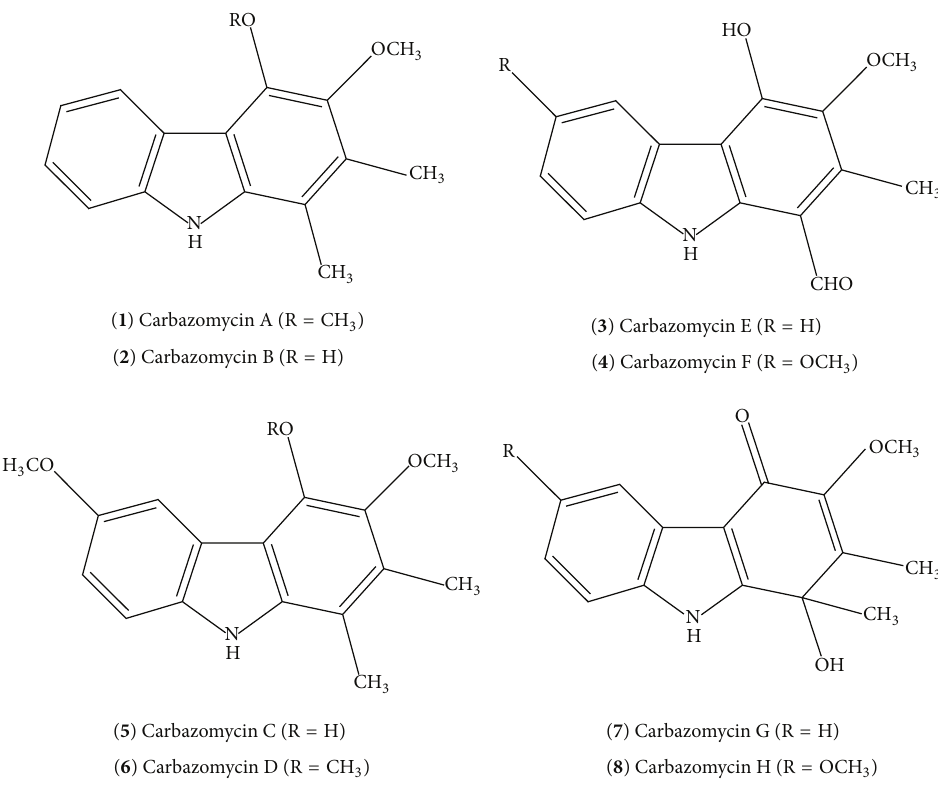
Figure 1: Carbazomycin alkaloids.